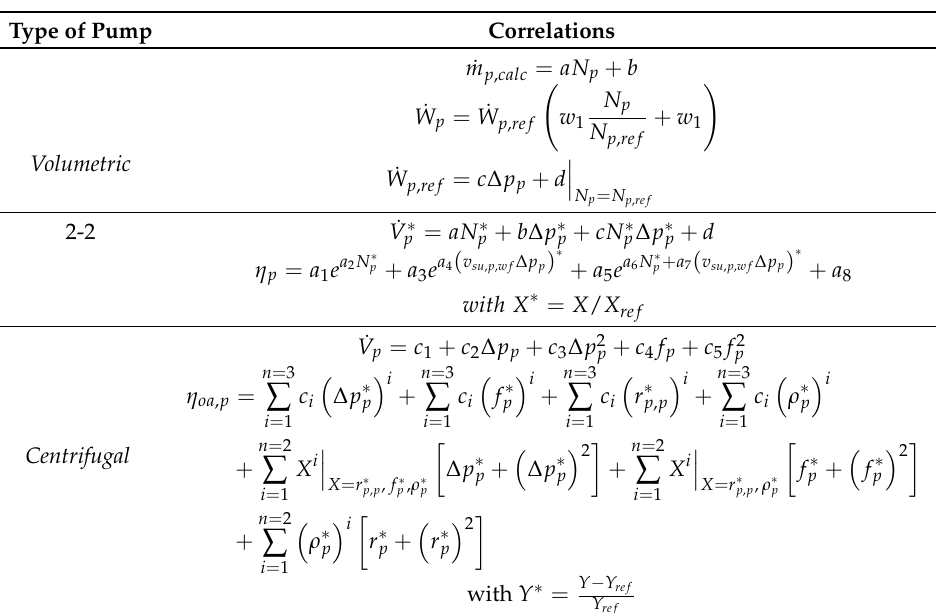
Table 1. Pump models